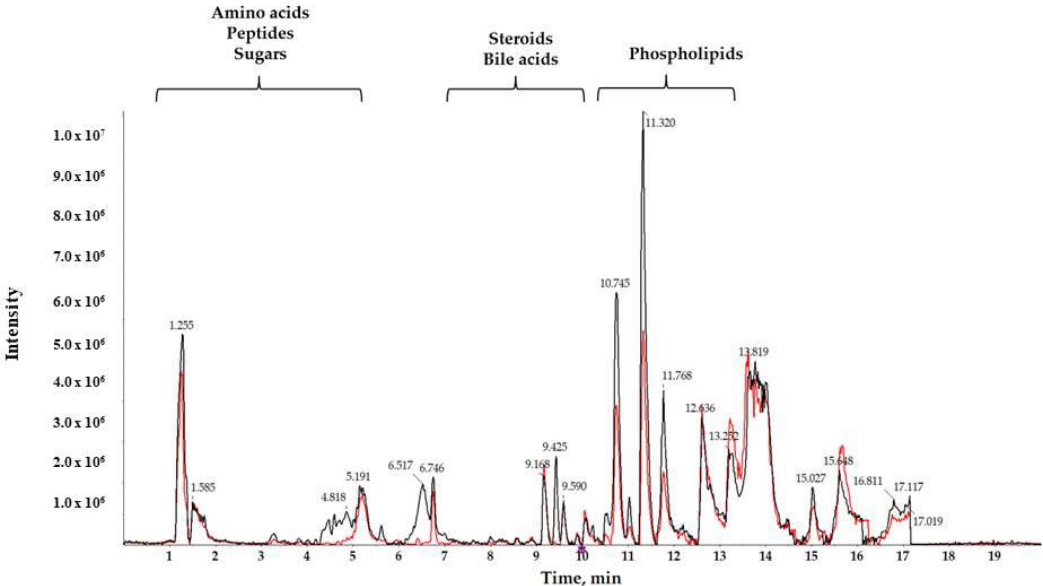
Figure 1. Characteristic liquid chromatography coupled to high resolution spectrometry (LC-HRMS) total ion chromatogram (TIC) of serum samples from T2DM (black) and T3cDM (red).